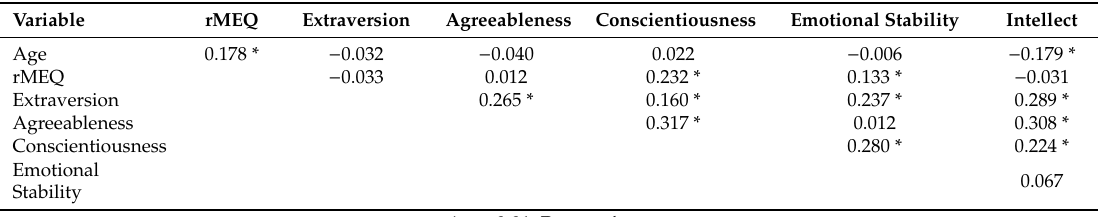
Table 5. Correlations (Pearson’s r) of age, reduced morningness-eveningness (rMEQ), and the domains of the IPIP 50 Big-Five questionnaire ( n = 712).